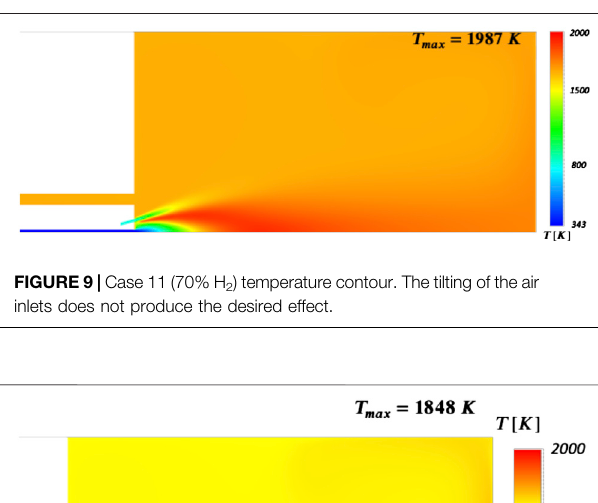
FIGURE 7 | Case 7 (70% H 2 ) temperature and OH contours.